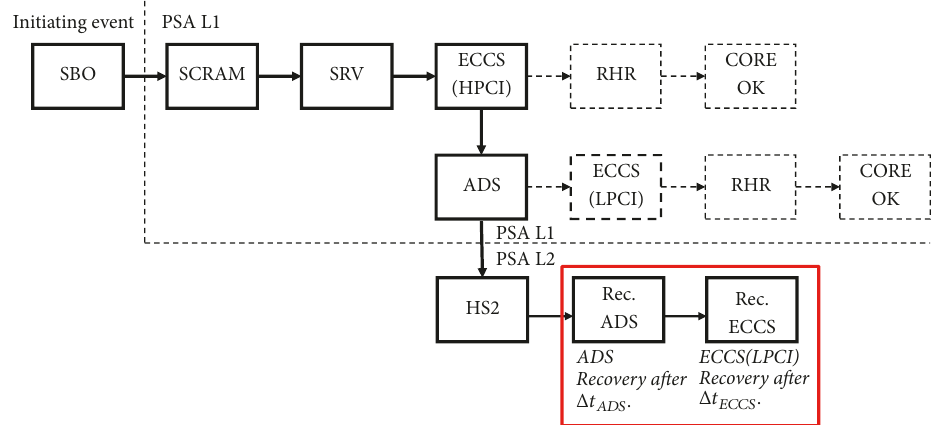
Figure 3: Block diagram for HS2 PDS and recovery of ADS and